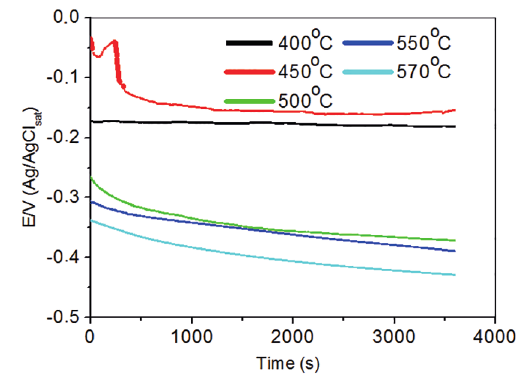
Figure 13: F-53 steel open circuit potential measurements at different nitriding temperatures for an immersion period of 4000 seconds.